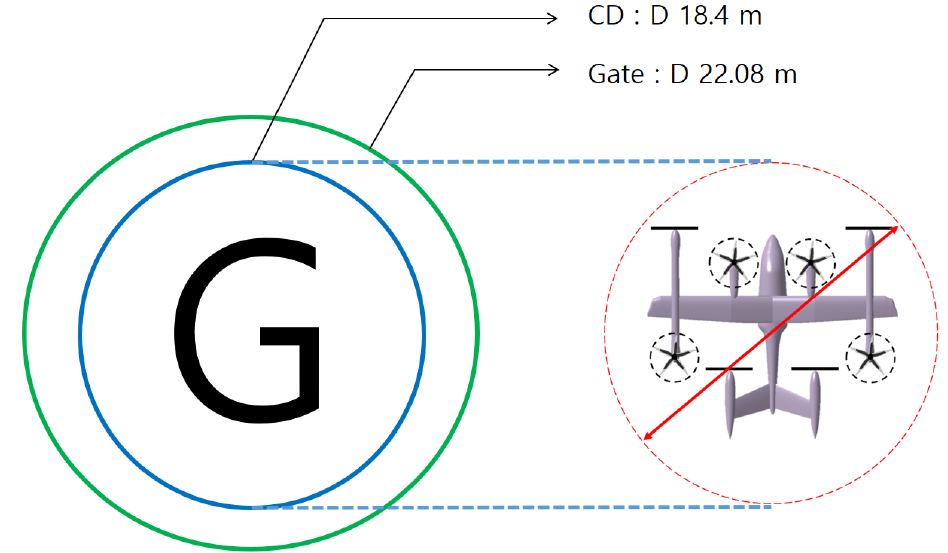
Figure 4. Gate size for S-A1 that comply with the FAA’s new regulations.